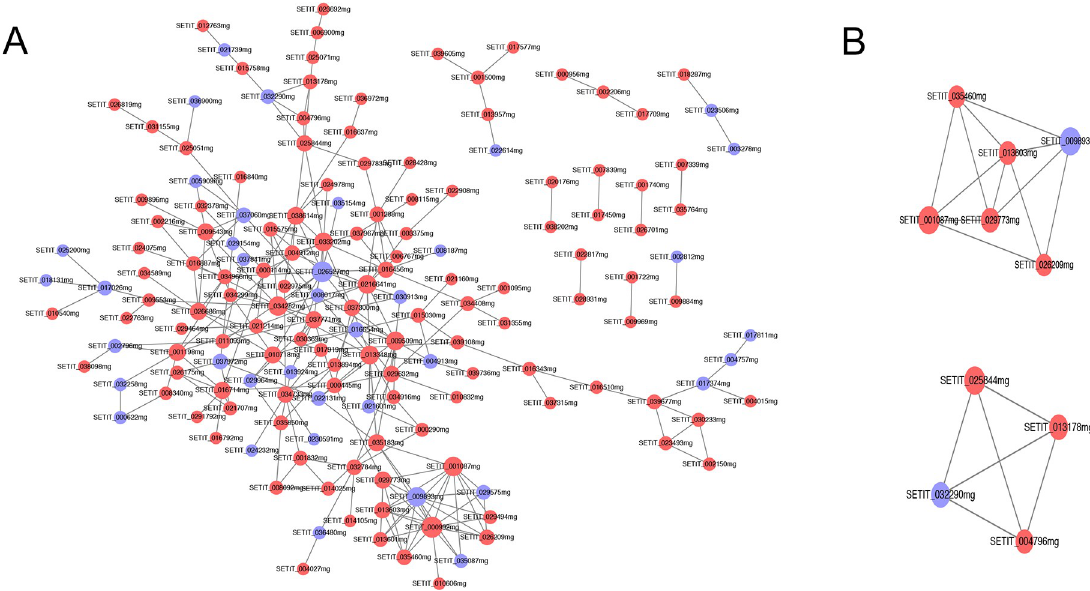
Fig 4. Protein-protein interaction network of differentially expressed genes. A, PPI network constructed from DEGs between groups D and DHA. B, two modules obtained from the PPI network. Red circles represent up-regulated DEGs; purple circles represent down- regulated DEGs. Gray lines represent protein interaction relationships. The larger the node, the higher the degree of interaction.